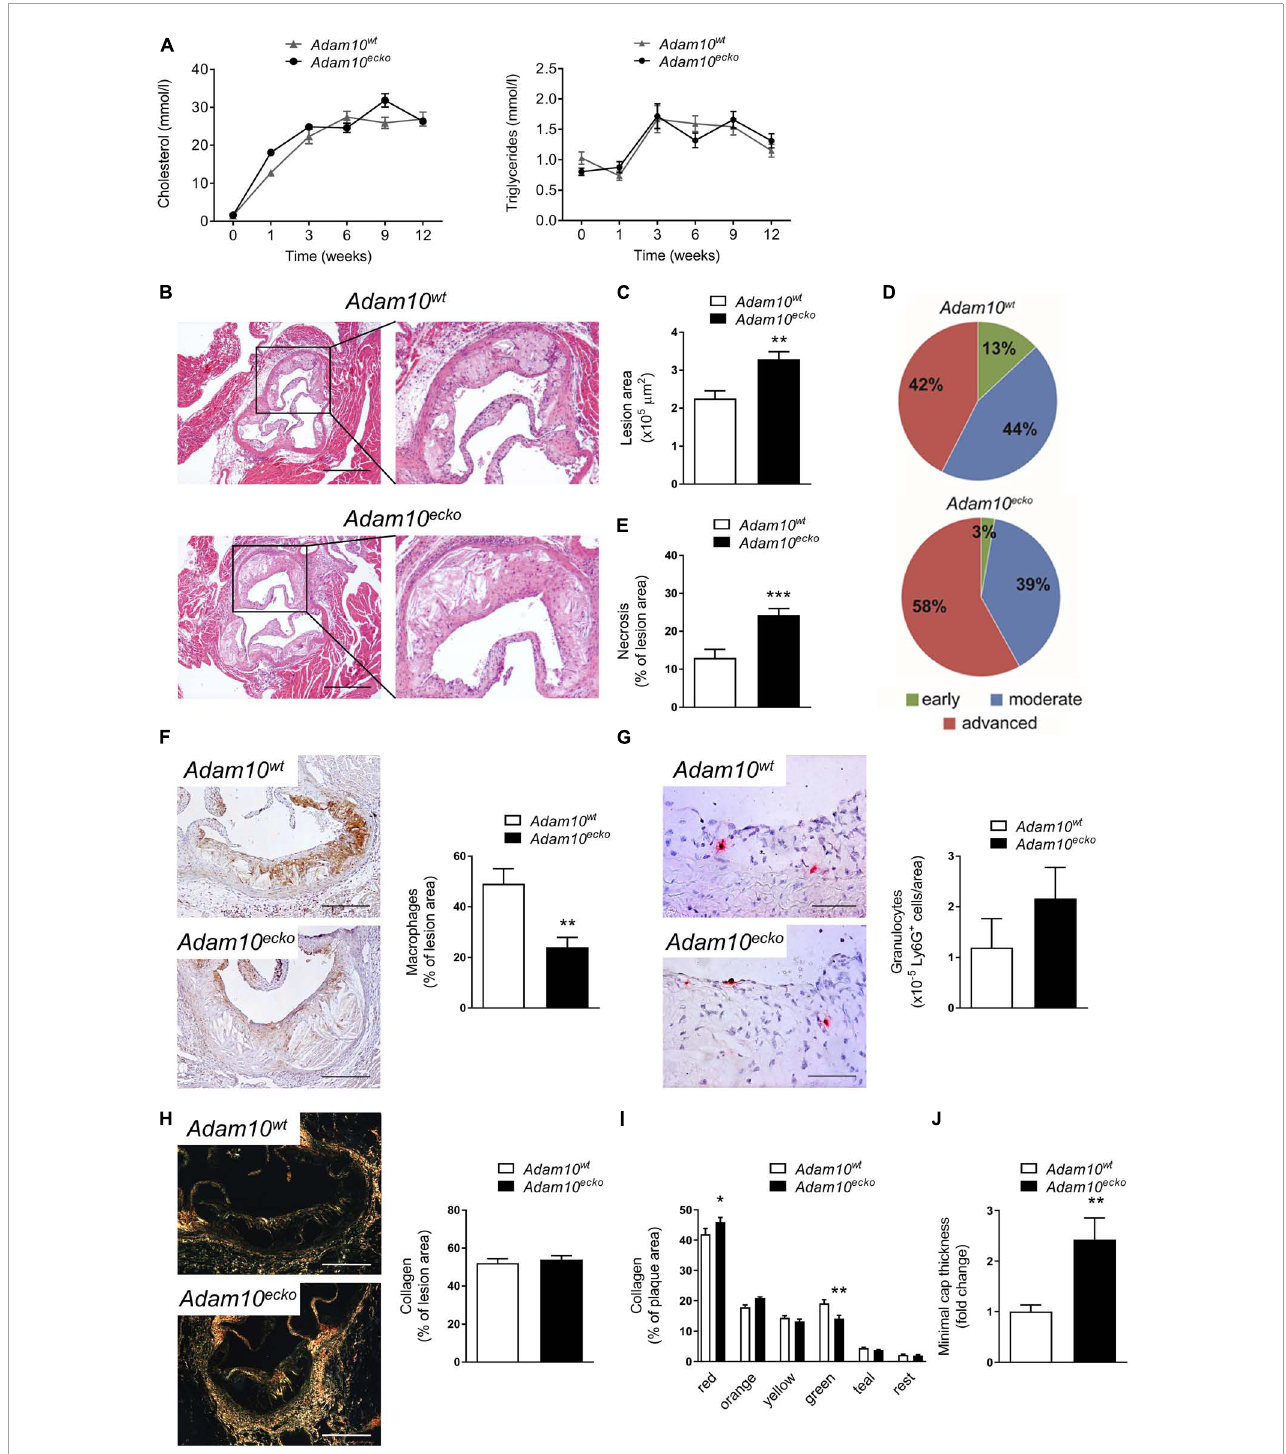
FIGURE1 Adam10 ecko significantly increases atherosclerotic lesion formation and intraplaque necrosis. Endothelial Adam10 deficient ( Adam10 ecko ) and wildtype mice ( Adam10 wt ) mice were rendered hyperlipidemic by AAV8-PCSK9 gene transfer, followed by 12 week western type diet feeding. (A) Plasma cholesterol and triglyceride levels ( n = 13–16). (B–D) Atherosclerotic lesion area (B,C) and plaque stage quantification (D) in the aortic root (H&E staining, n = 13–15; scale bar, 400 µ m). Indicated percentages reflect the total number of valves (three per mouse) that are classified as belonging to the respective plaque stage. (E) Quantification of necrotic core area ( n = 13–16). (F–H) Representative images of (immuno)histological stainings for macrophages ( F , MAC3 + ; n = 12–14; scale bar, 200 µ m), granulocytes ( G , Ly6G + , n = 13–16; scale bar, 100 µ m) and total collagen ( H , Sirius Red imaged with polarized light; n = 13–16; scale bar, 200 µ m) in aortic root atherosclerotic plaques with quantification. (I) Quantification of different collagen fibers in the plaques, ranging from thick–mature collagen (red), to loosely packed–thin collagen fibers (green) ( n = 13–16). Sidak’s multiple comparison test was conducted to determine the statistical significance between the two groups. (J) Quantification of minimal cap thickness ( n = 13–15). * p ≤ 0.05; ** p ≤ 0.01; *** p ≤